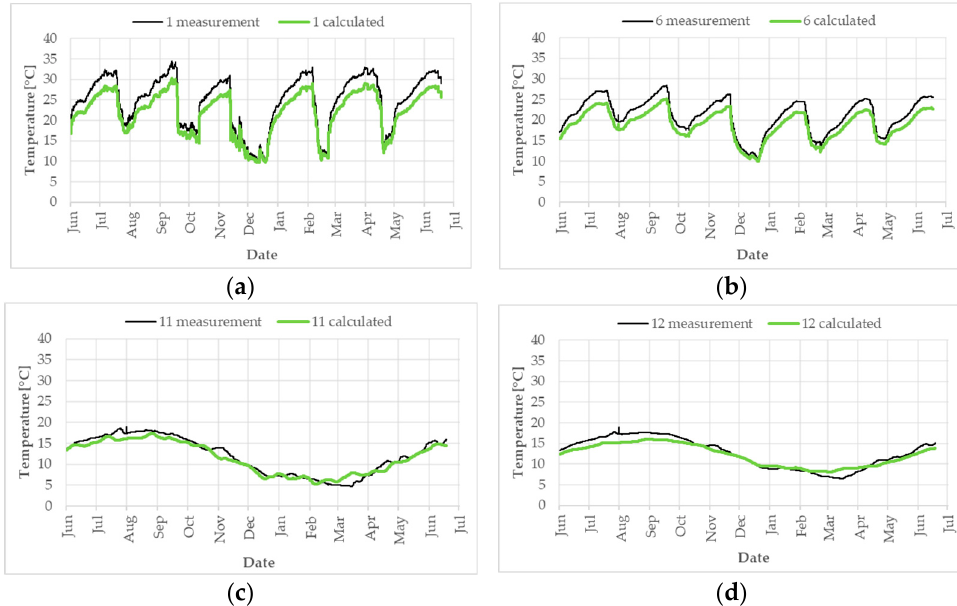
Figure 9. Waveforms for the measured and calculated temperature at the points: ( a ) no. 1; ( b ) no. 6; ( c ) no. 11; ( d ) no. 12.